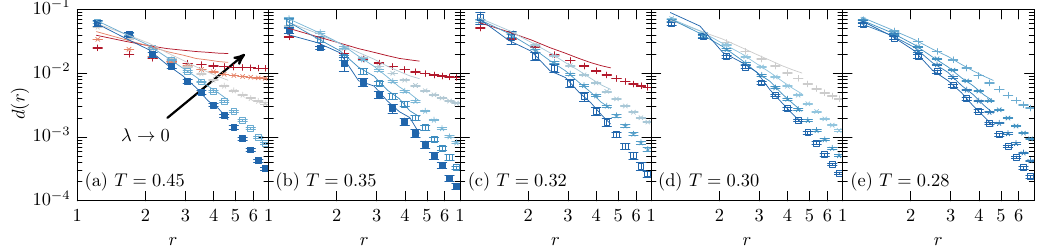
Figure 14: Finite size effects on the decay profile for saddles at (a) T = 0.45, (b) T = 0.35, (c) T = 0.32, (d) T = 0.30, and (e) T = 0.28. We show the data of N = 1000 by lines and those of N = 3000 by symbols. The continuous change in color from blue to red corresponds to the change of λ shown in Tab. 4. We show the data above the mobility edge in red, those below the mobility edge in blue.